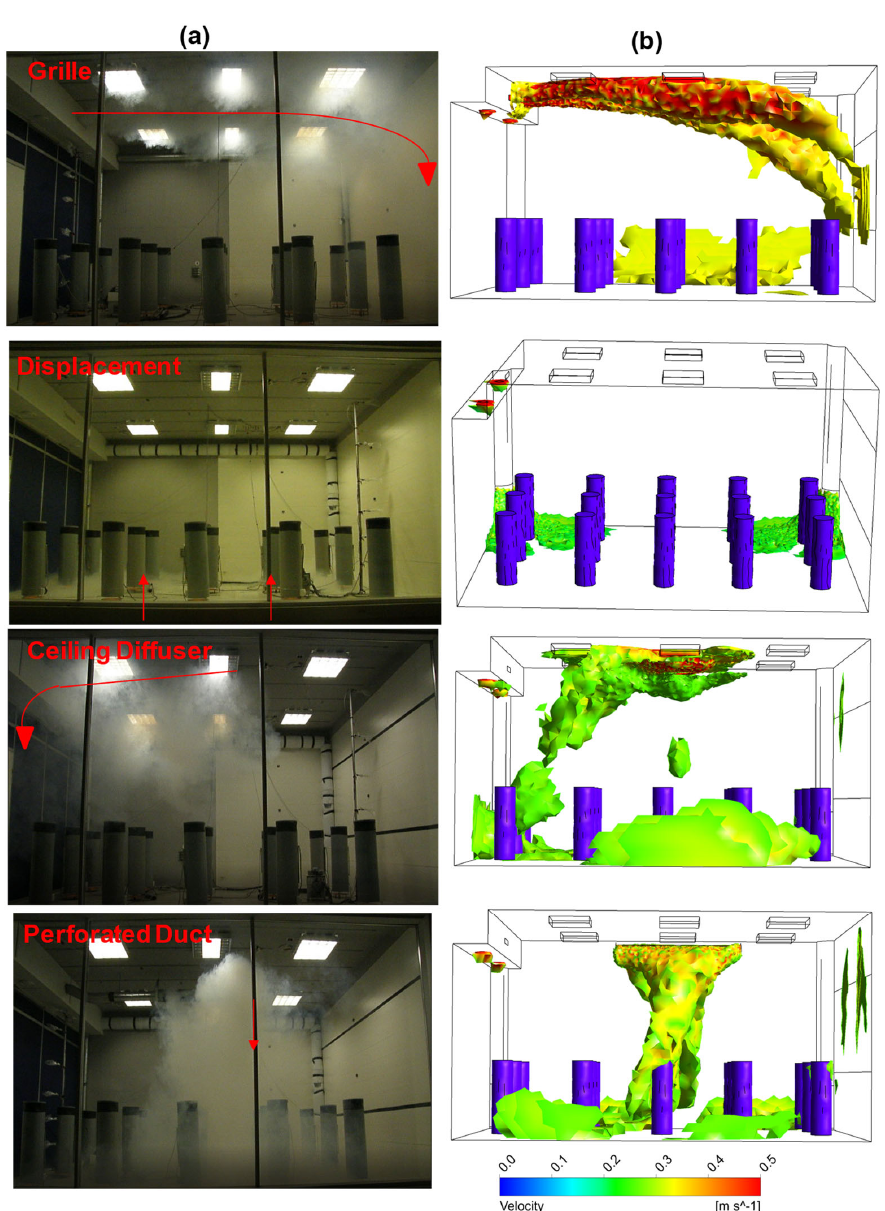
Figure 5. Smoke visualization in summer conditions ( a ) with the full-scale laboratory test and ( b ) by CFD simulation.